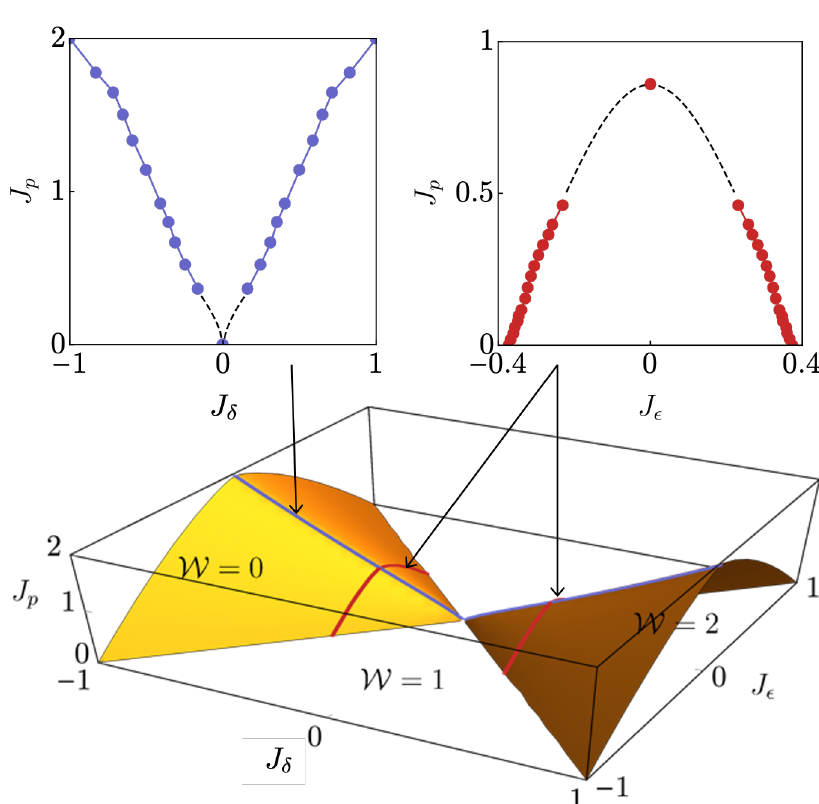
Figure 9: The phase diagram of the two coupled network system as a function of J δ , J ε , and J . The regions under the critical surfaces have W = 0,2 and the region above p the critical surfaces has W = 1. The insets show cross sections indicated by the blue and red lines in the 3D plot. The black dashed lines are interpolations; in particular, in the left inset, we interpolate according to J Sec. 4.5), whereas in the right inset the interpolation is